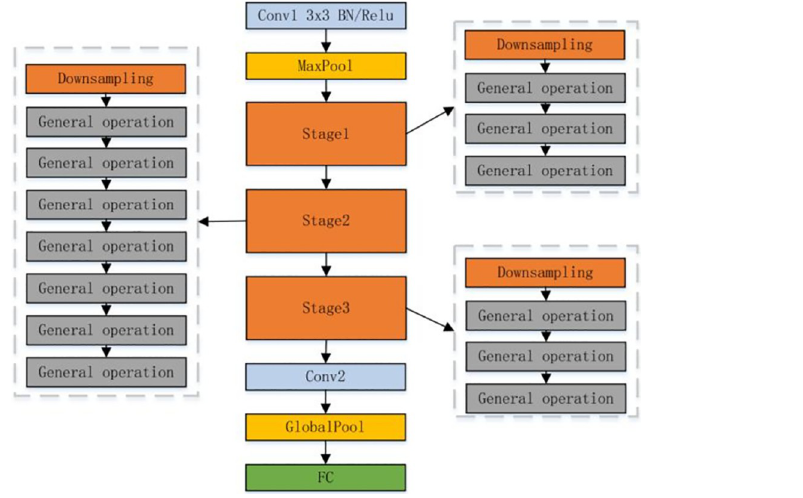
Fig 2. Shufflenet_V2 network